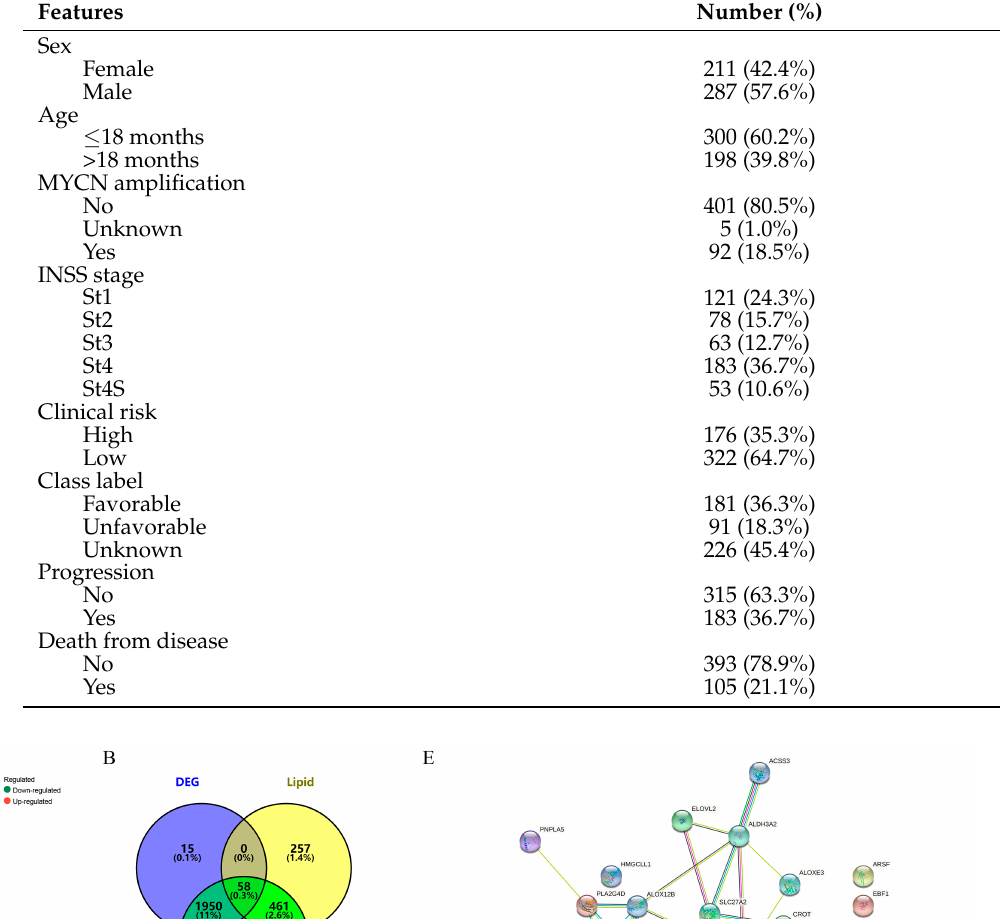
Table 1. Clinical pathological parameters of NB patients in the training set.